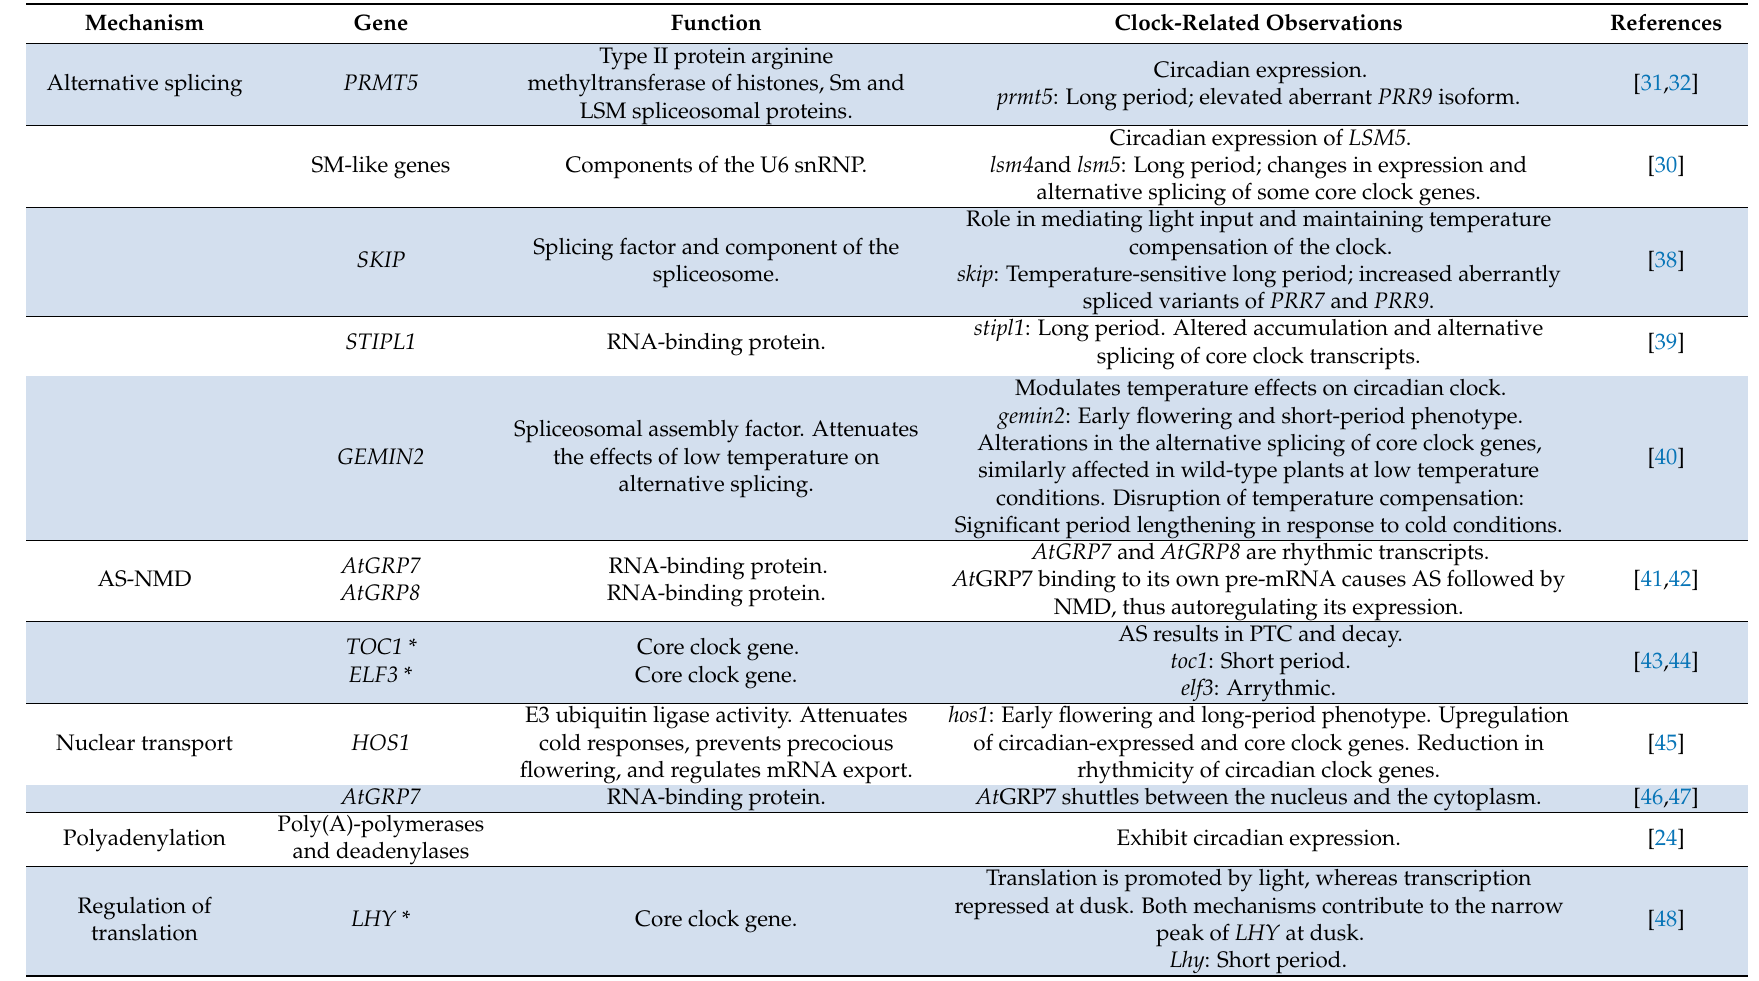
Table 1. Genes involved in post-transcriptional mechanisms implicated in clock